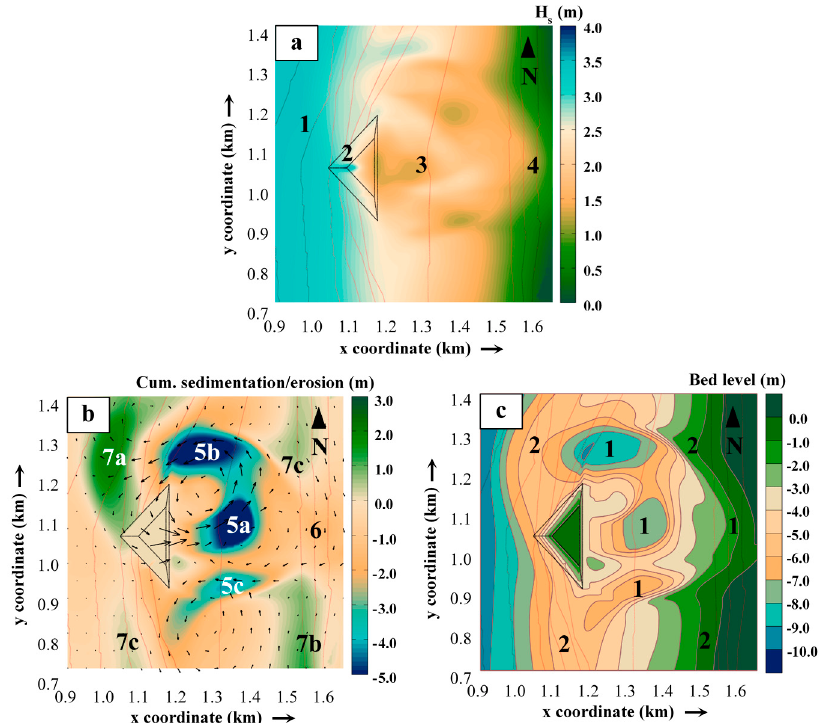
Figure 9. E ff ect of storm wave condition with west wave direction on an MFAR for ( a ) significant wave heights dissipation for XBeach model, ( b ) cumulative sedimentation and erosion (arrows represent wave velocity vectors) for XBeach, and ( c ) configuration of bed level. The indicated numbers in ( a ) and ( b ) relate to: 1—substantial significant wave heights in the structure outward zone; 2—wave shoaling at the structure apex; 3—wave shoaling in the structure inward zone due to depth decrease; 4—wave progression towards shoreline (indicating erosion problems); 5a—substantial erosion due to local scouring from the increase in waves velocity and small wave refraction (due to wave propagation at di ff erent depths); 5b—substantial erosion due to local scouring from the combination of incoming waves from the north and the vortex (increased waves velocity); 5c—substantial erosion due to local scouring from the intersection of both vortexes in the same direction; 6—noticeable erosion near shoreline; 7a—substantial accretion in the structure outward zone; 7b—substantial accretion southeast of the structure, near shoreline; 7c—accretion near shoreline and southwards the structure. The indicated numbers in ( c ) relate to 1—erosion phenomenon; 2—sedimentation phenomenon.